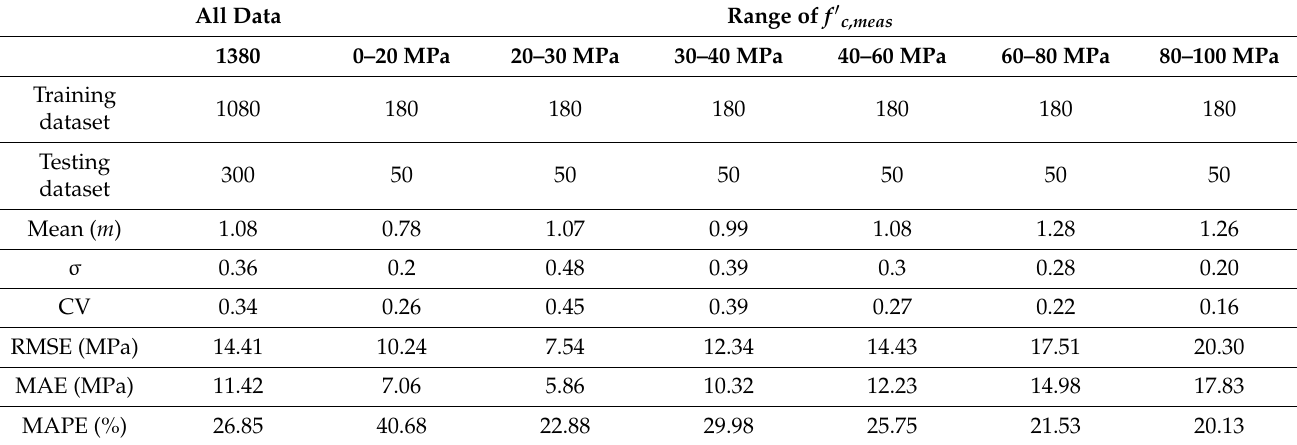
Table 3. Analysis accuracy of ML trained with 1080 data